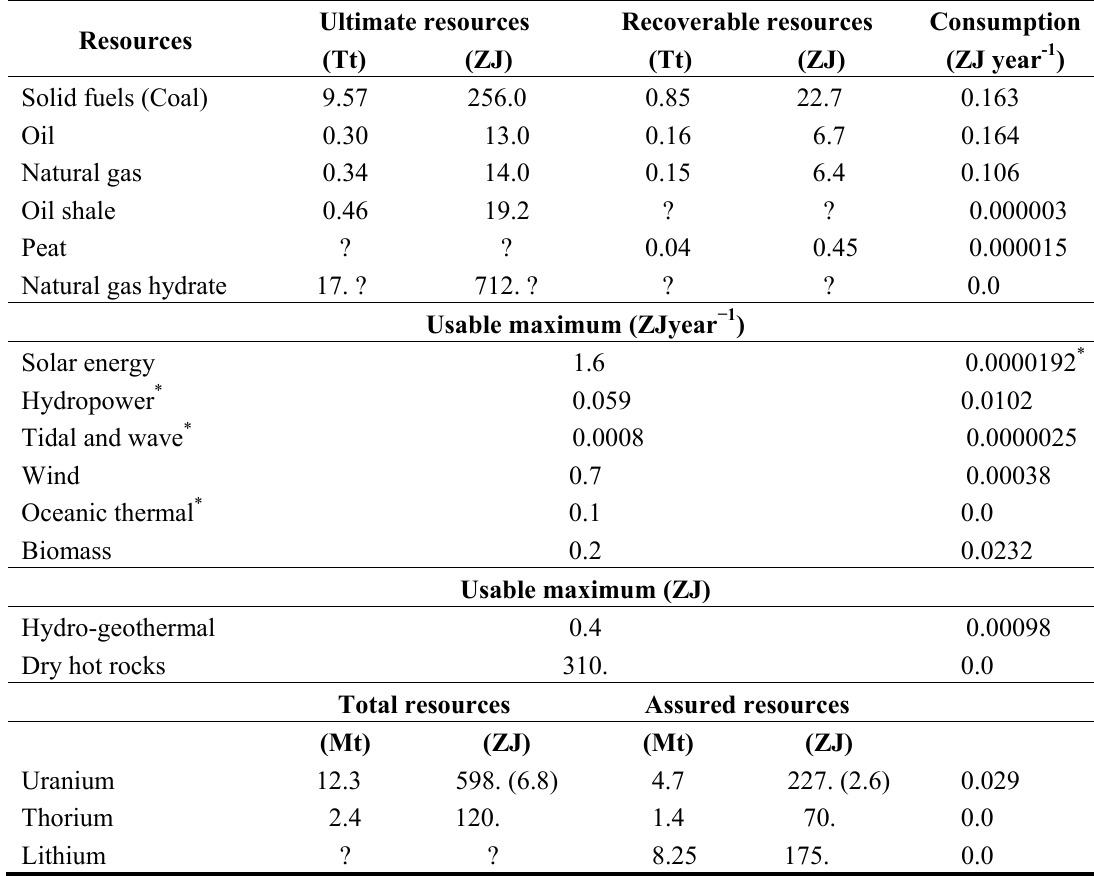
Table 2. Summary of energy